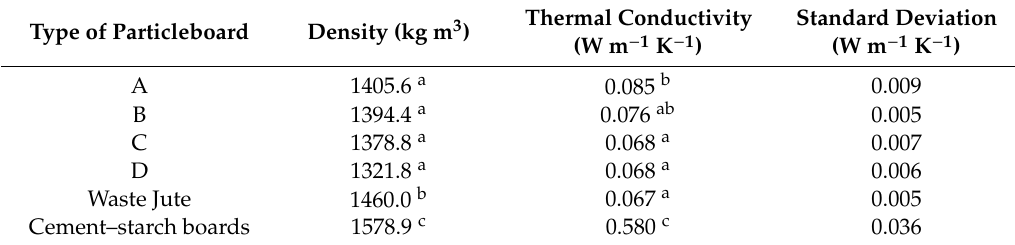
Table 5. Thermal conductivity of the